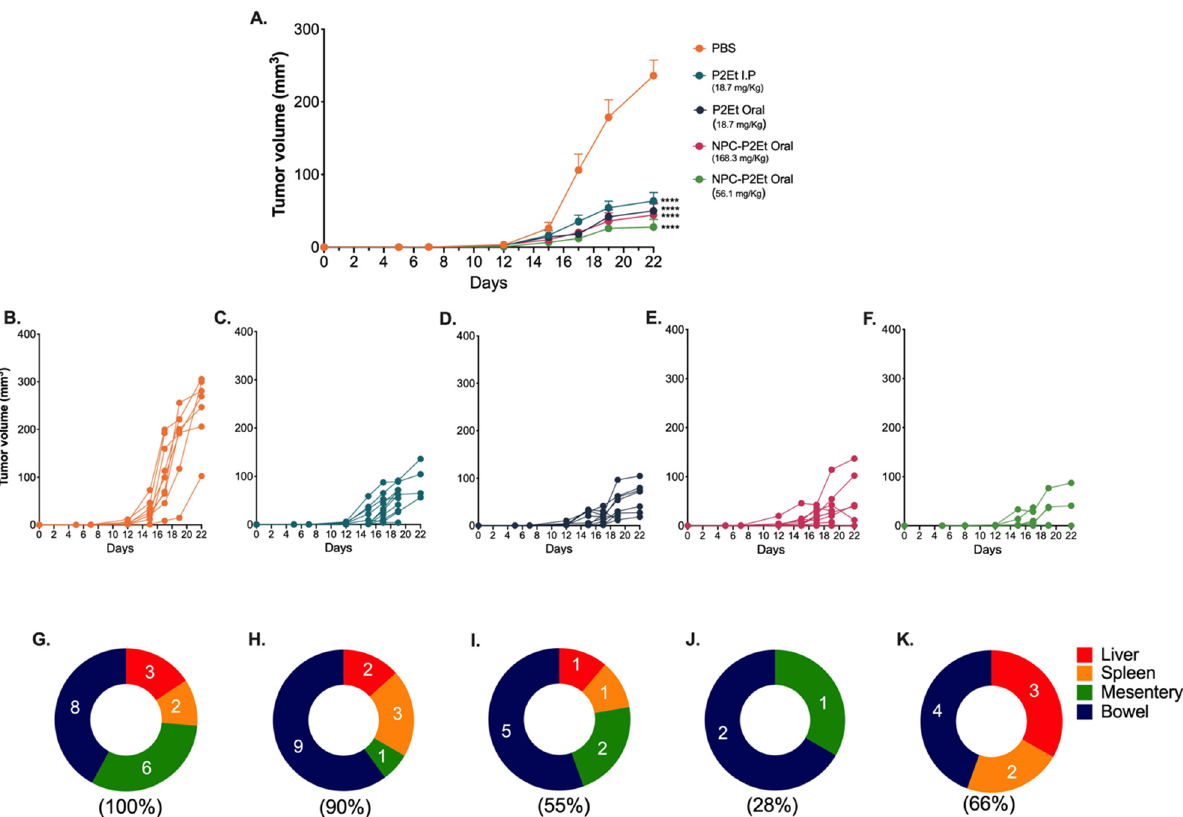
Figure 3. NPC-P2Et delay tumor growth and macro-metastasis in breast cancer model. 4T1 tumor growth curve after treatments ( A ). 4T1 individual tumor volume after PBS ( B ), P2Et I.P (18.7 mg/Kg) ( C ), P2Et Oral (18.7 mg/Kg) ( D ), NPC-P2Et Oral (168.3 mg/Kg), ( E ), NPC-P2Et Oral (56.1 mg/Kg) treatment ( F ). Distribution of multi-organ metastasis of 4T1 tumors for all groups, after PBS ( G ), P2Et I.P (18.7 mg/Kg) ( H ), P2Et Oral (18.7 mg/Kg) ( I ), NPC-P2Et Oral (168.3 mg/Kg), ( J ). NPC-P2Et Oral (56.1 mg/Kg treatment ( K ). In all cases, data are represented as the mean ± SEM. The p values were calculated using a Dunne tt ´s multiple comparison test. **** p < 0.0001.